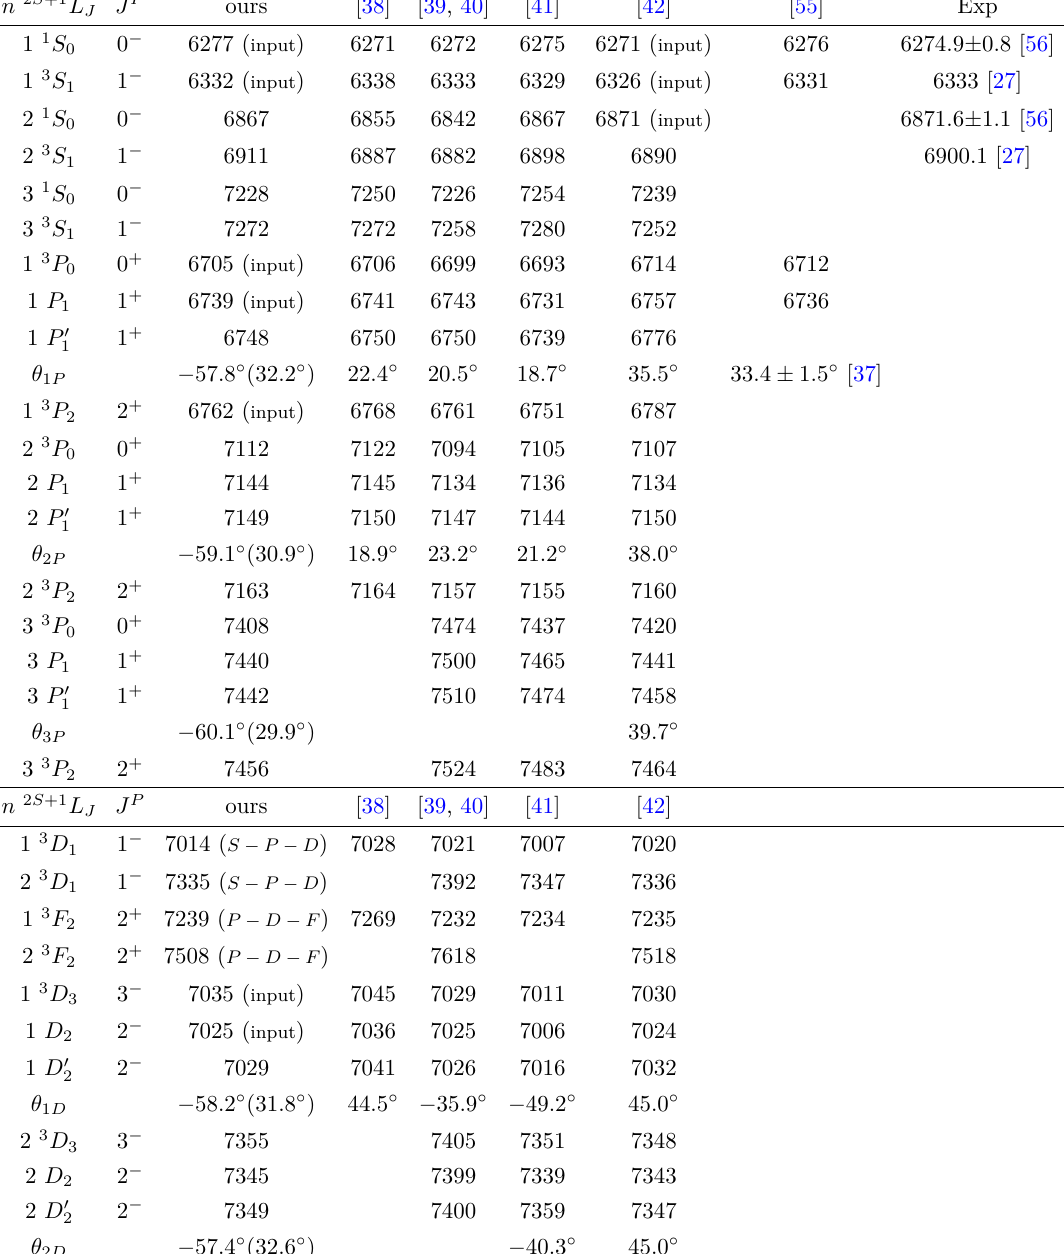
Table 1 . Mass spectra and mixing angles of the B c